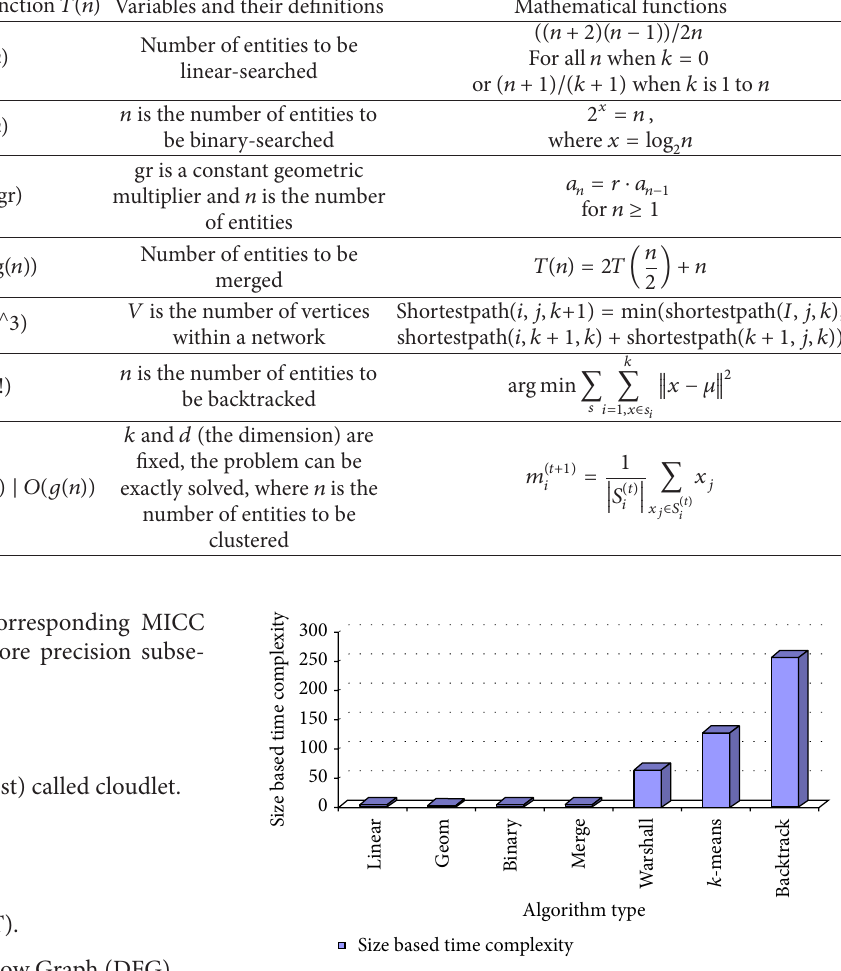
Figure 2: Size based time complexity of various